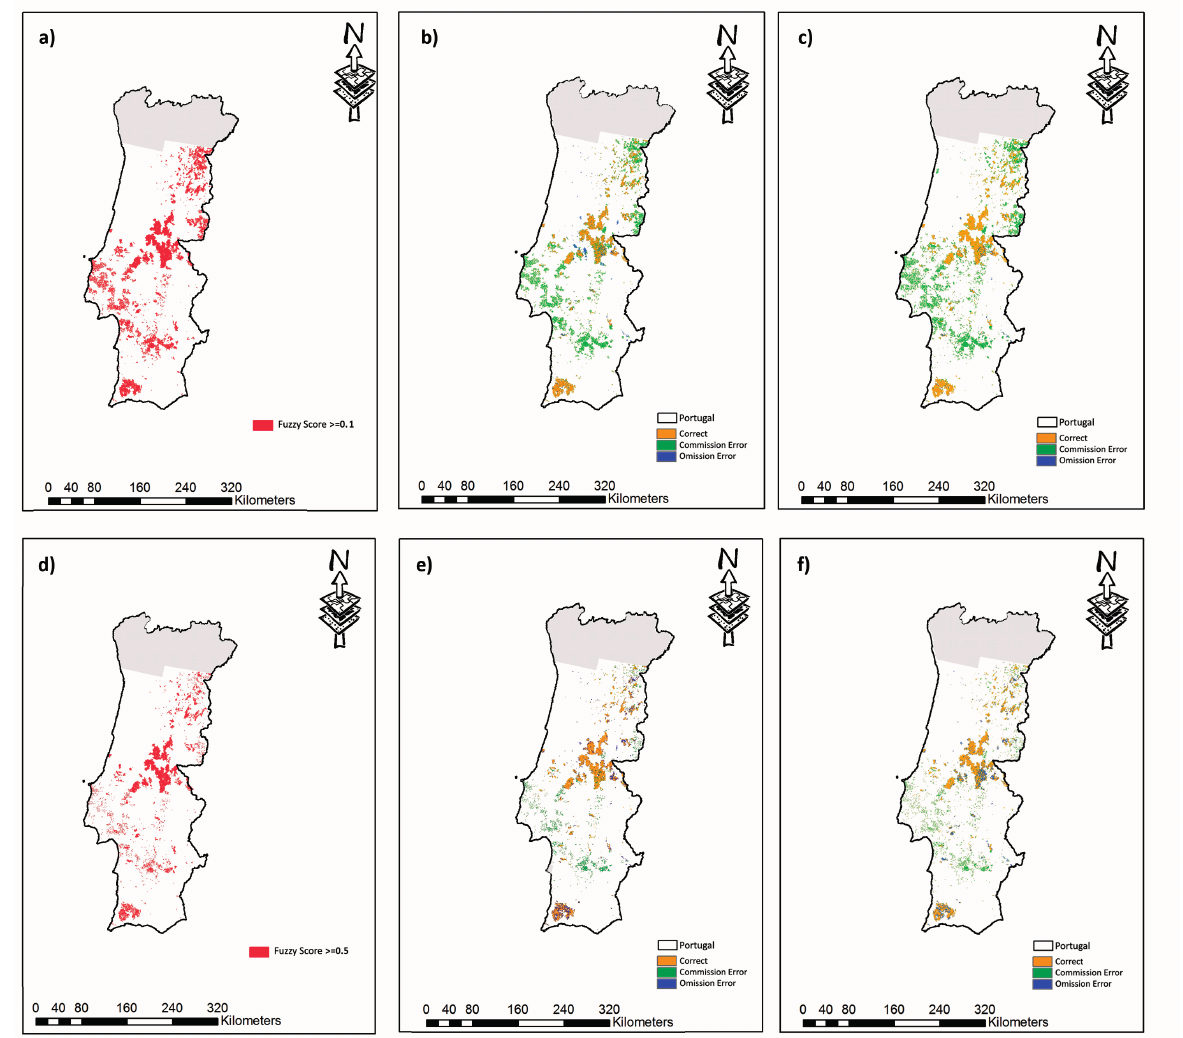
Figure 11. ( a – c ) the optical + SAR burned area map (first column) and its accuracy map (second column) compared to the accuracy of the burned area map derived with only optical data (third column) in the case of threshold of the fuzzy score 0.1; ( d – f ) the same for the case of threshold of the fuzzy score